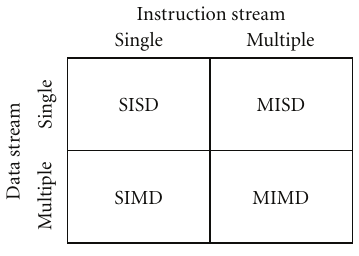
Figure 1: Flynn’s taxonomy (1966)